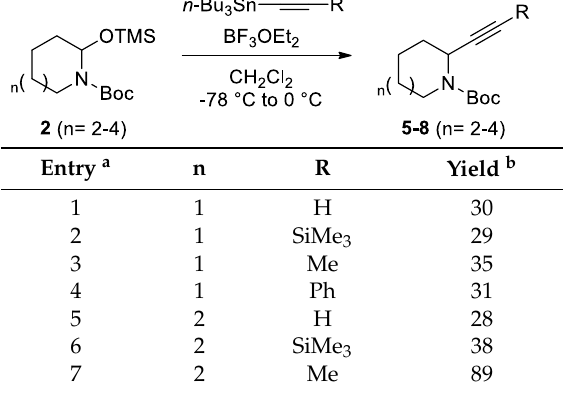
Table 3. Acetylenylation of N , O -acetal TMS ethers.